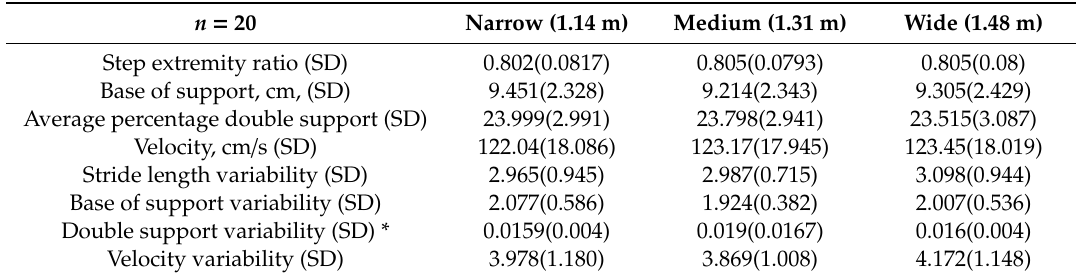
Table 1. Mean spatiotemporal parameters for the three hallway width conditions.